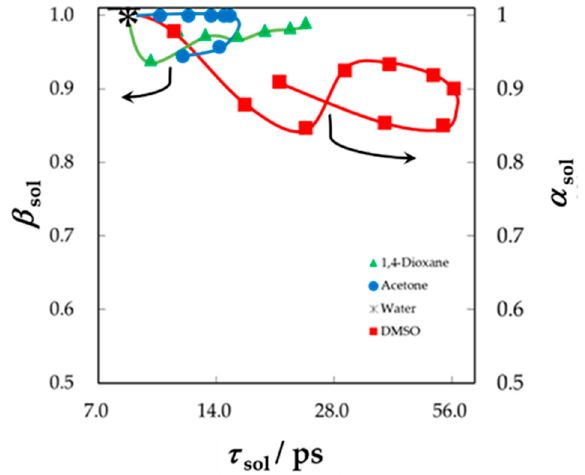
Figure 11. The τ – β diagram for bulk solvent mixtures. The relaxation time distribution parameter β sol of the Cole-Cole equation was used for aqueous solutions of 1,4-dioxane and acetone, and the parameter α sol of the Cole-Davidson equation was used for aqueous solutions of DMSO.